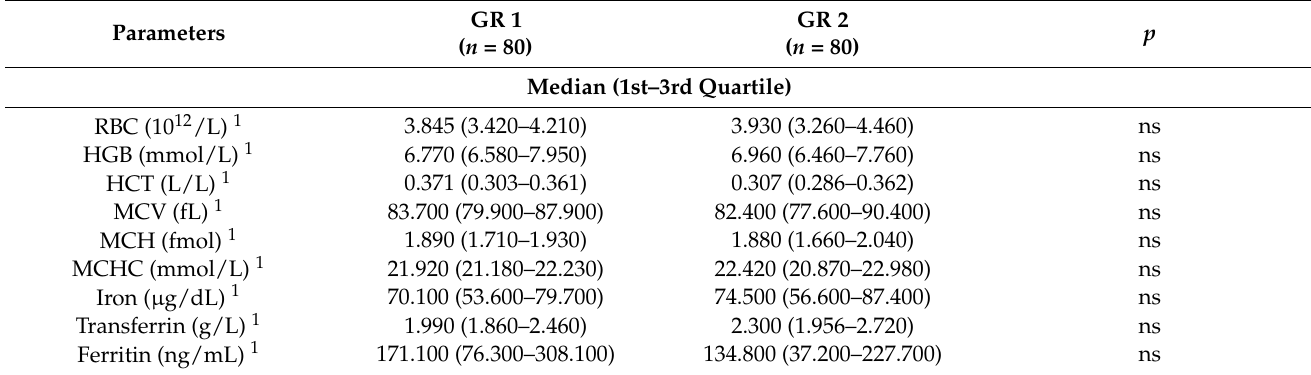
Table 3. Comparison of anaemia-related parameters between the study groups at the baseline.